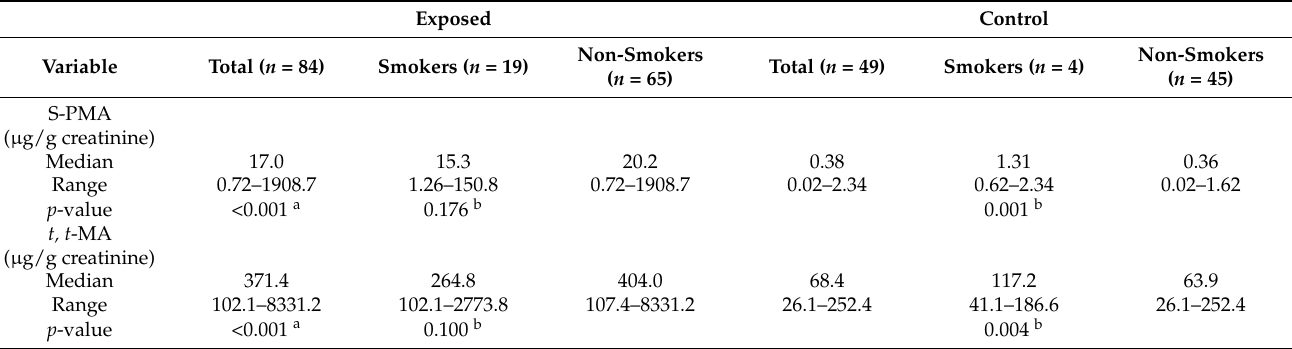
Table 2. Summary statistics for urinary metabolite excretion in control and exposed subjects.